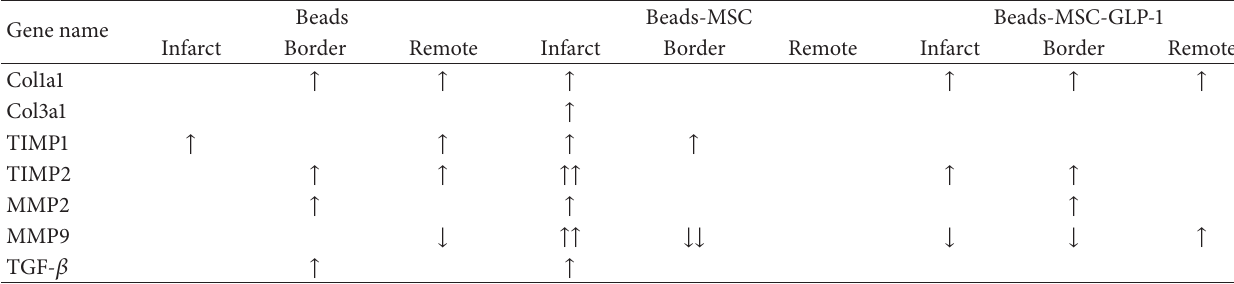
Table 2: Changes in expression levels of genes involved in ECM remodeling one week after MI. Large changes in expression are demonstrated by arrows ( ↑ = 2–20x increase, ↑↑ = 20–50x increase.